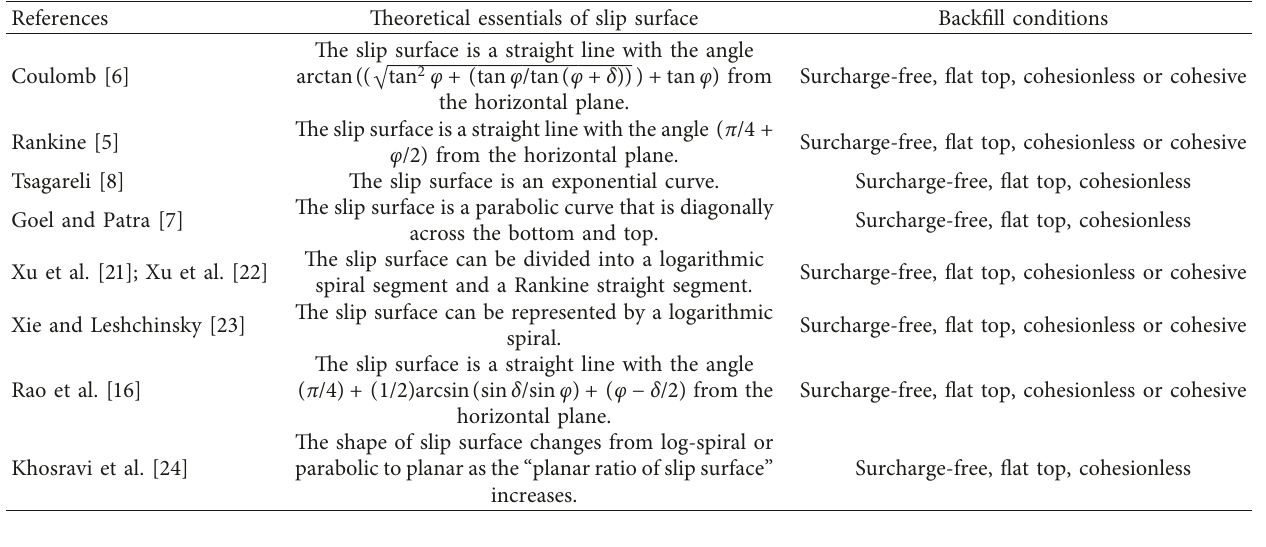
Table 1: Various formulas for slip surface when in active state.